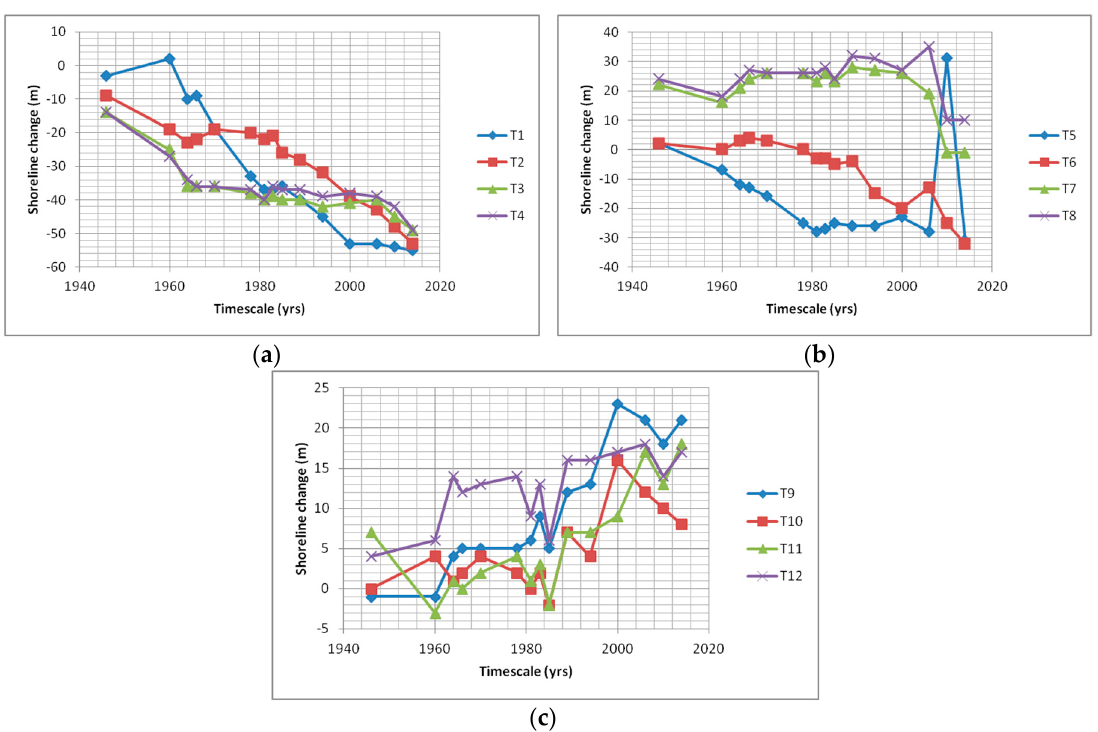
Figure 5. Transect change timeseries from the 1941 baseline, for ( a ) southern; ( b ) central and ( c ) northern beach sectors.